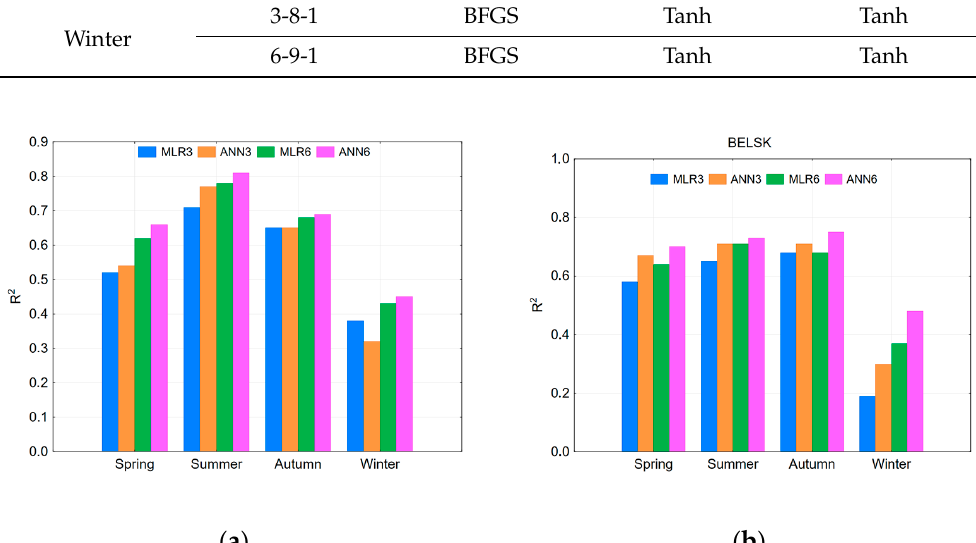
Figure 8. Coefficient of determination (R 2 ) for Racibórz ( a ) and Belsk ( b ) by model and season. MLR3—MLR based on a set of 3 input data, ANN3—ANN based on a set of 3 input data, MLR6— MLR based on a set of 6 input data, ANN6—ANN based on a set of 6 input